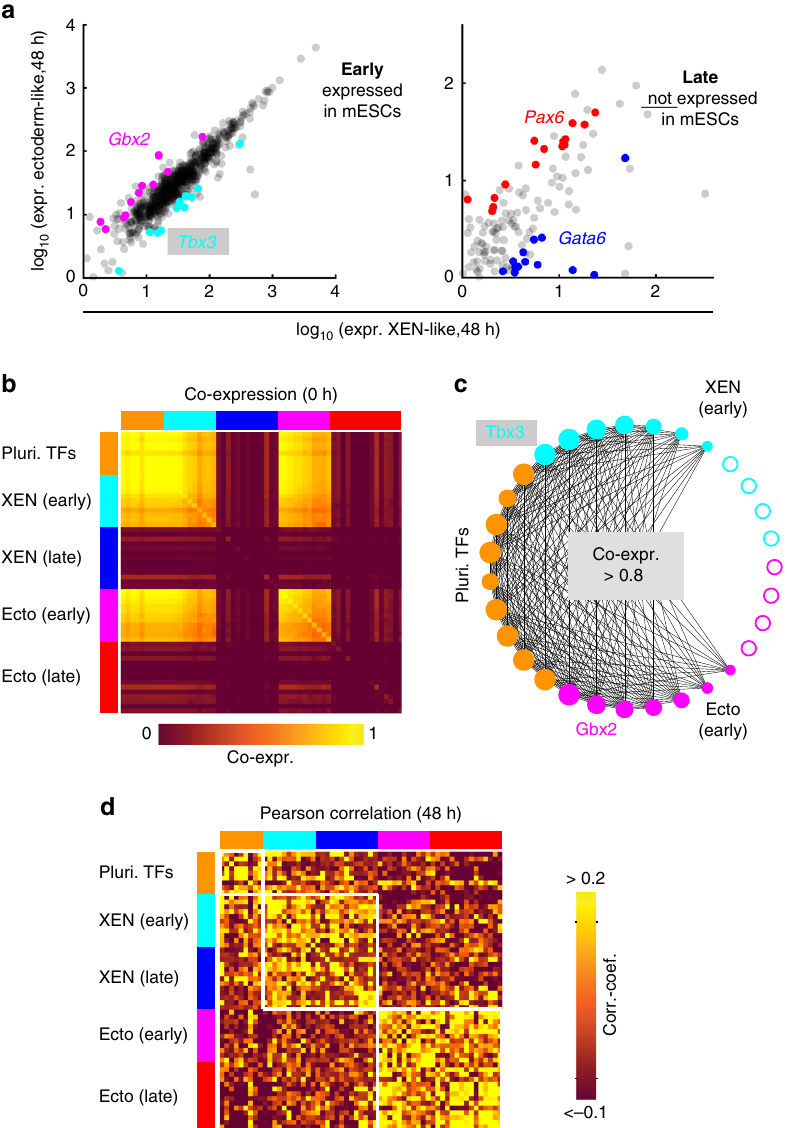
Fig. 6 Distinct co-expression and correlation patterns identi fi ed two classes of lineage speci fi c transcriptional regulators. a Expression of transcriptional regulators in ectoderm-like and XEN-like cells identi fi ed in the SMART-seq2 data set. Genes that were signi fi cantly differentially expressed after 48 h of RA exposure are shown in red or pink (overexpressed in ectoderm-like cells) and blue or cyan (overexpressed in XEN-like cells), respectively. The two panels contain genes, which are present in the pluripotent state (early, left panel) or absent in the pluripotent state (late, right panel). A list of all identi fi ed genes is given in Supplementary Fig. 9b. b Co-expression of transcriptional regulators in the pluripotent state. The gene set comprised the differentially expressed transcriptional regulators identi fi ed here (see a ), as well as pluripotency related transcription factors 51 (see Supplementary Fig. 9b). Co-expression was calculated using gene expression measured by SMART-seq2. Co-expression of two genes was quanti fi ed as the fraction of cells in which the expression of both genes exceeded a certain threshold value (see Methods). c Co-expression network in the pluripotent state. Two genes are connected by an edge if their co-expression exceeds 0.8. The gene set comprised XEN speci fi c regulators (cyan nodes) and ectoderm speci fi c regulators (pink nodes) that are expressed in the pluripotent state (early factors), as well as pluripotency factors 51 (orange nodes). The radius of solid nodes is proportional to the number of connections to other nodes. Nodes without any connections are depicted as open nodes. d Pearson correlation between transcriptional regulators after 48 h of RA exposure. The gene set is the same as in b . Pearson correlation was calculated using gene expression measured by